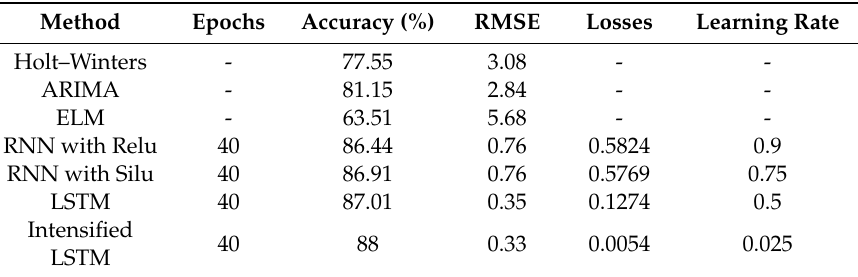
Table 1. Performance comparison table.